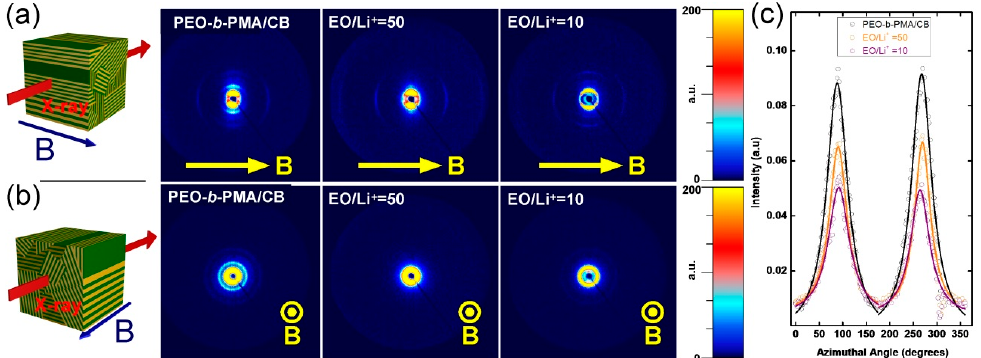
Figure 5. ( a ) Room temperature 2D SAXS data of EO-MA/CB samples at different EO:Li + ratios, where the field was kept horizontal with respect to the X-ray detector’s plane (top panel) and the corresponding azimuthal intensity profiles of the BCP super structure peak ( c ). ( b ) Room temperature 2D SAXS data of the same samples when the field was applied normal with respect to the X-ray detector’s plane (bottom panel).